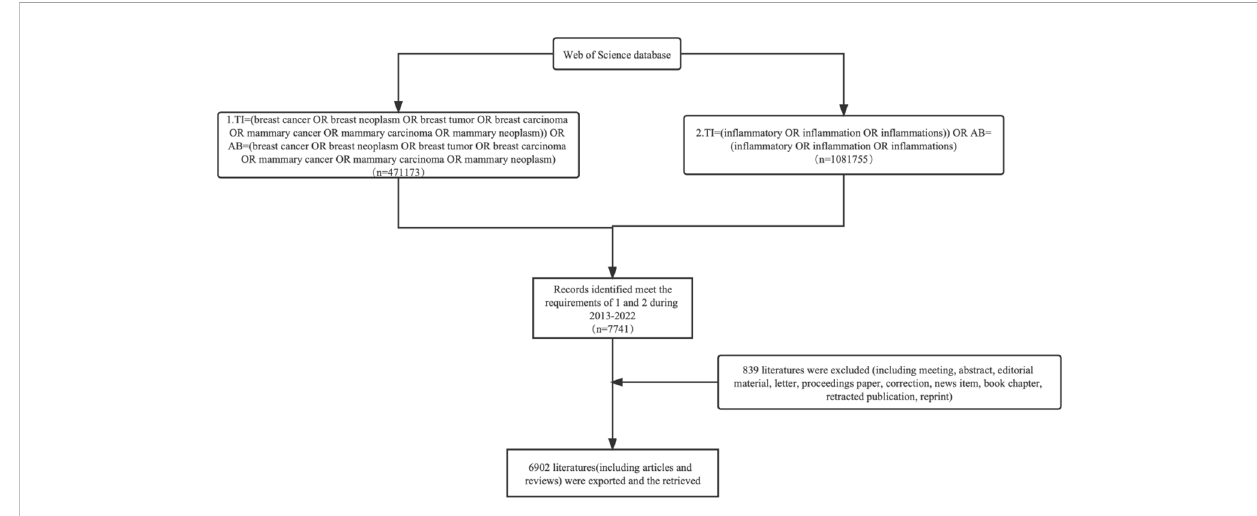
FIGURE 1 Literature-sifting process fl